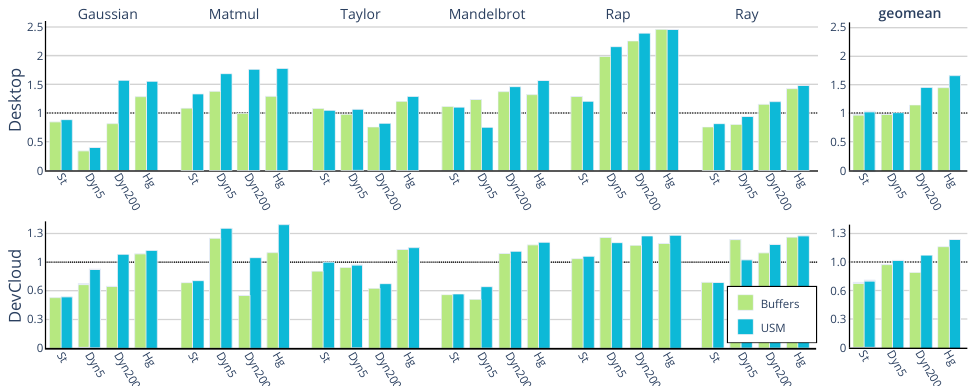
Figure 5. The balancing efficiency for a set of benchmarks when doing CPU-GPU co-execution in Desktop and DevCloud nodes.